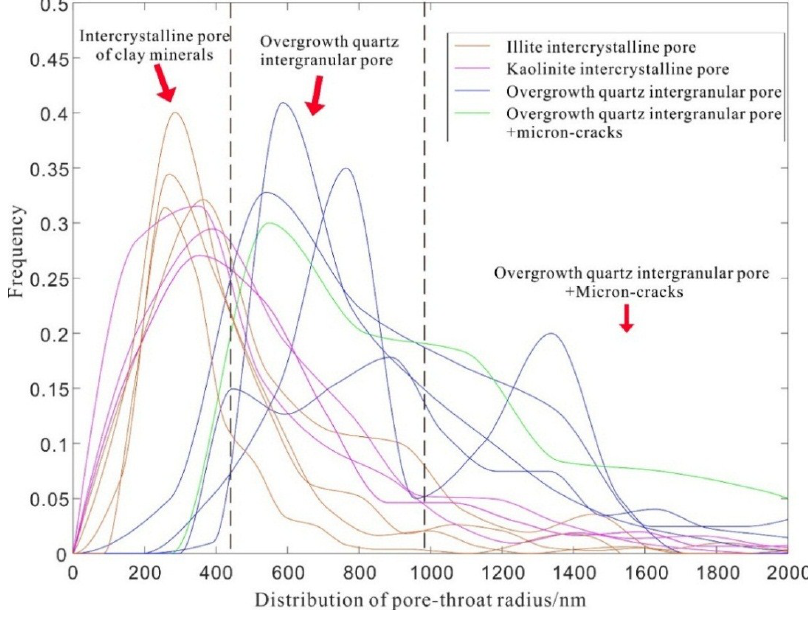
Figure 7. Distribution of the nano-scale throat radius of the He8 section.